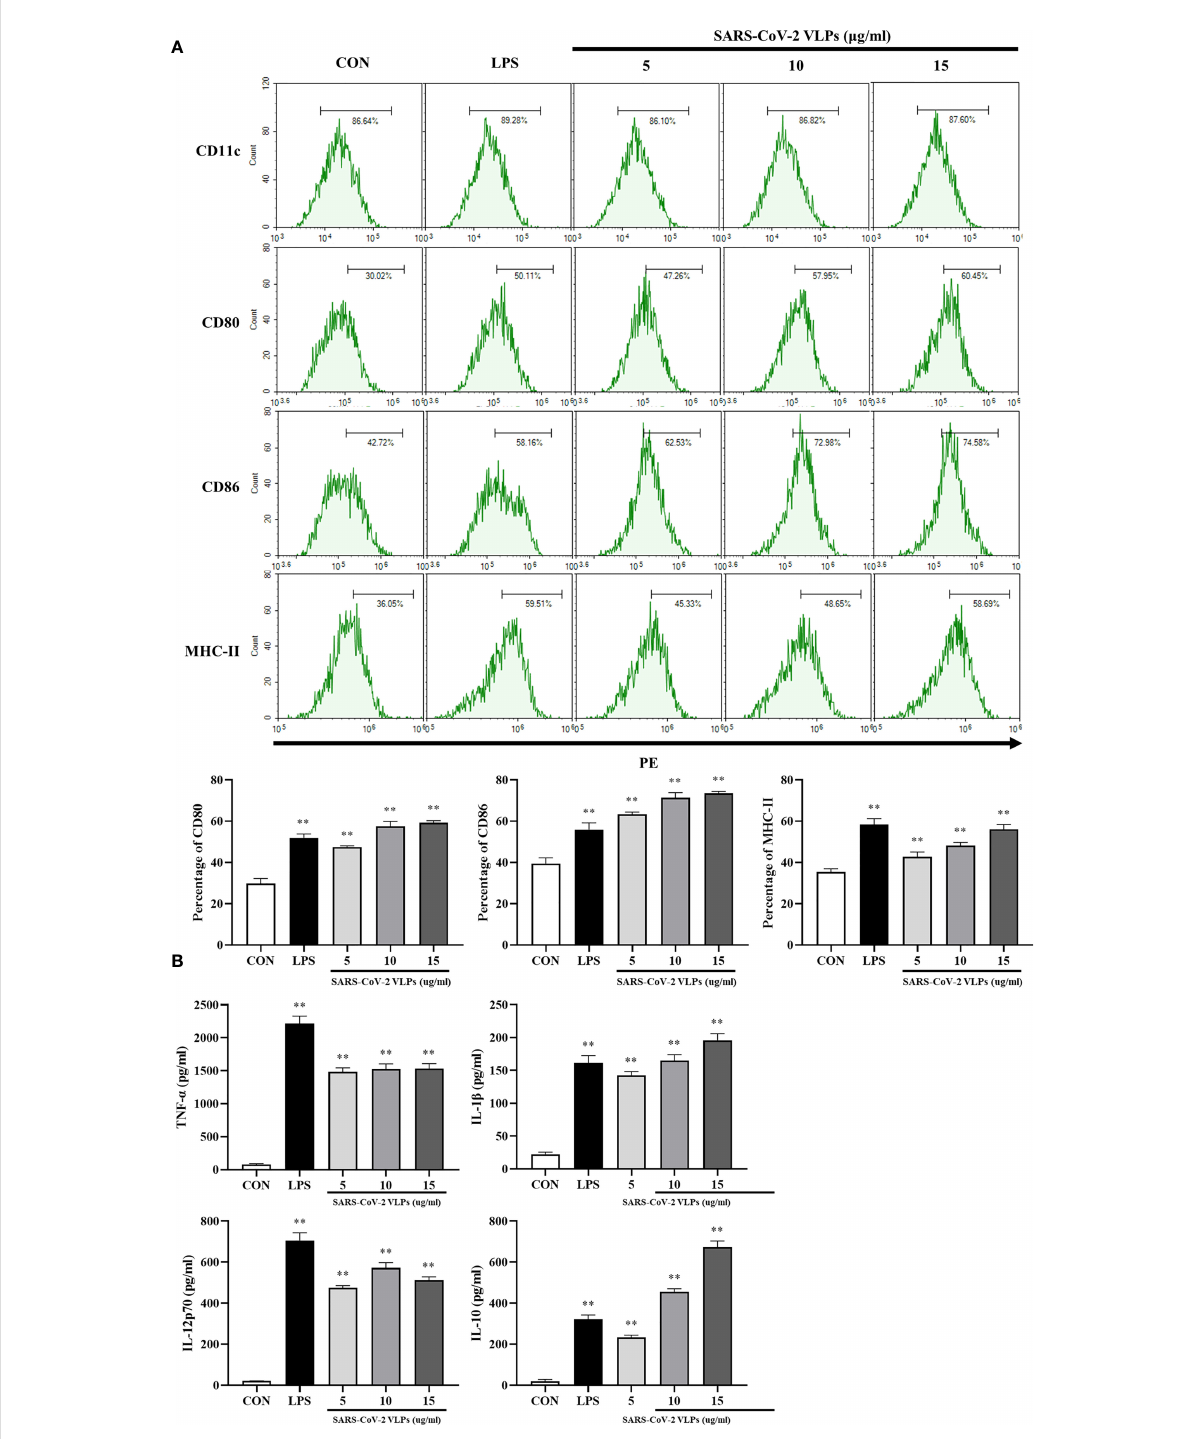
FIGURE 3 SARS-CoV-2 VLPs induce DCs maturation. DCs were treated with SARS-CoV-2 VLPs (5, 10, or 15 m g/mL) or LPS (50 ng/mL) for 24 h. Untreated DCs were used as control (CON). (A) Flow cytometry was used to analyze the expression of surface molecule markers on DCs. The percentages are indicated in the histogram. Results are the representative of three experiments with similar data. (B) ELISA was used to determine the levels of TNF- a , IL-1 b , IL-12p70, and IL-10 in SARS-CoV-2 VLP-treated or LPS-treated DCs. Data are the means ± SE of three experiments. ** P < 0.01 versus untreated control